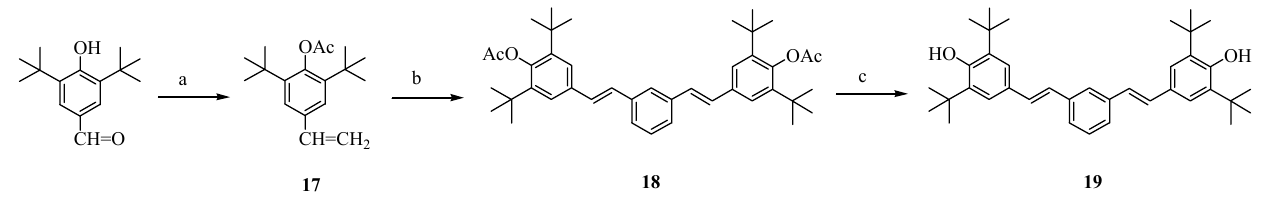
Figure 4. Synthesis of precursor 19 to model system 3